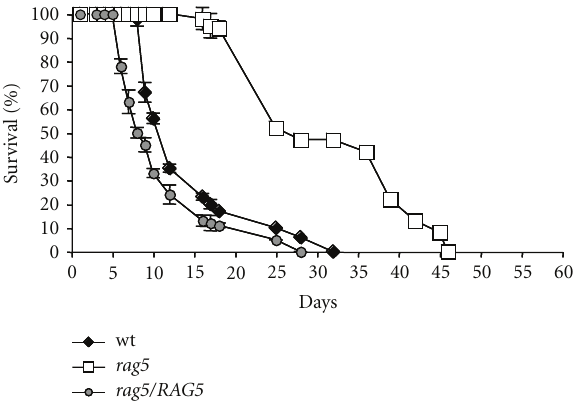
Figure 2: Evaluation of gene dosage of RAG5 in determining the lifespan. Comparison of chronological survival in YNB medium of wt and mutant lacking RAG5 and the same strain overexpressing RAG5 . Survival was assessed in minimal medium for plasmid maintenance. Over time, aliquots of cultures were counted and serial dilutions were plated on solid medium. Colony forming units were counted after 3 days. Data are representative of five independent experiments, mean ±